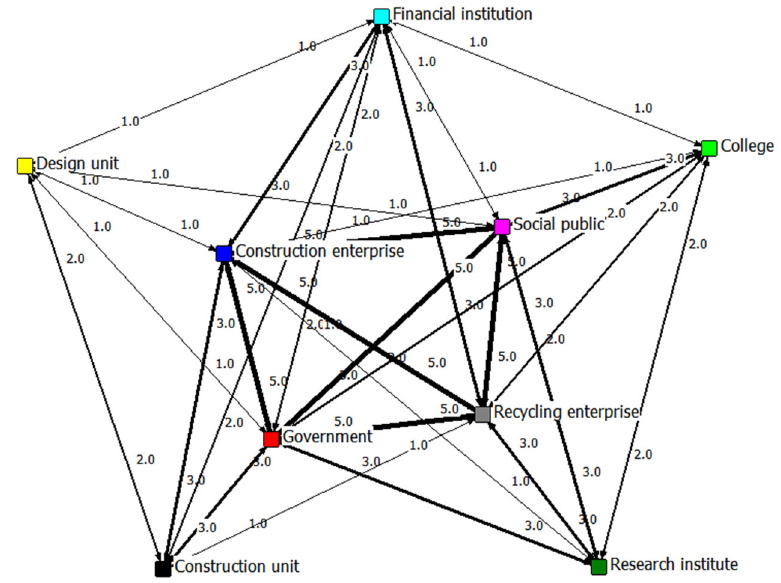
Figure 2. Social network model of CWR stakeholders.